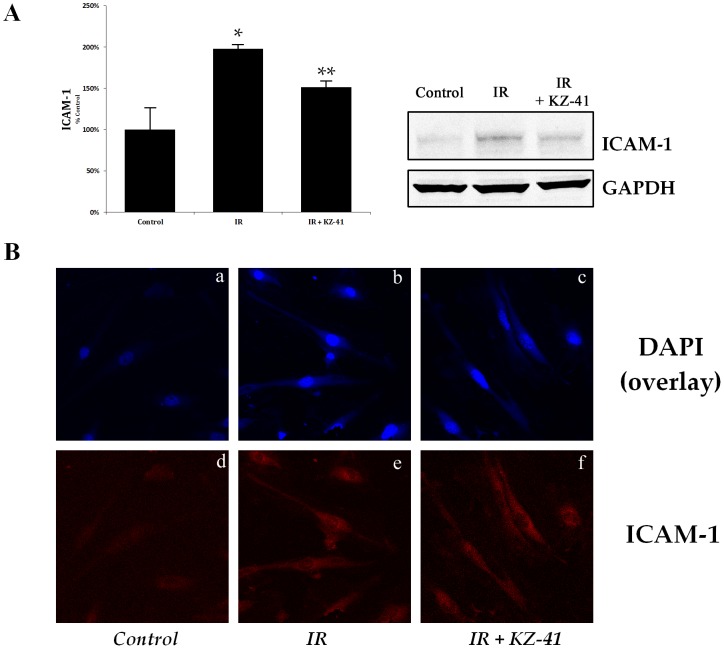
ICAM-1 up-regulation in irradiated RECs.A) Immunoblotting of ICAM-1 from IR-RECs after 24 hours show a significant up-regulation compared to unirradiated cells; treatment with KZ-41 (10 µM) reduces ICAM-1 levels by nearly 24% (Mean ± SD; *P<0.05, **P<0.05; n = 3).B) Confocal microscopy of RECs from flow-chamber slides. Top panels (A-C; Control, IR and IR+KZ-41, respectively) represent overlay images of DAPI and ICAM-1. Lower panels, D-E represents ICAM-1 immunoreactivity.